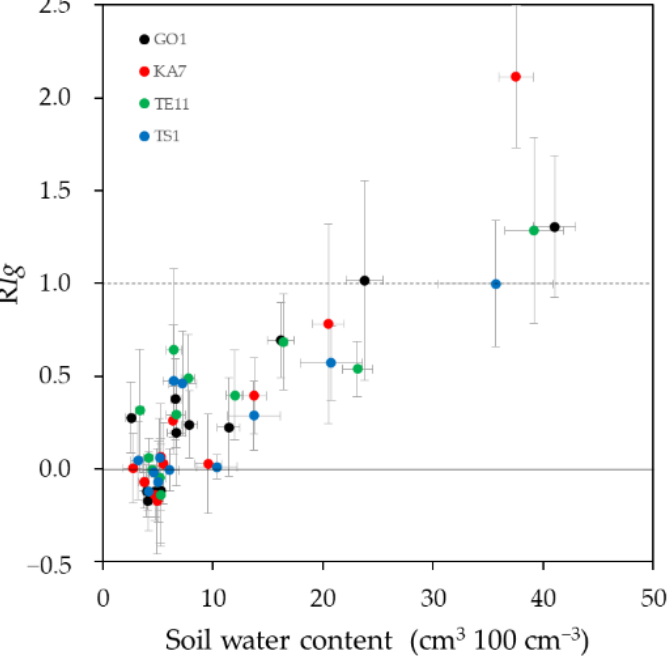
Figure 3. Relationship between the stomatal conductance index ratio (R Ig ) and the soil water content under the conditions of drought treatment. Black, red, green, and blue correspond to the clones GO1, KA7, TE11, and TS1, respectively.